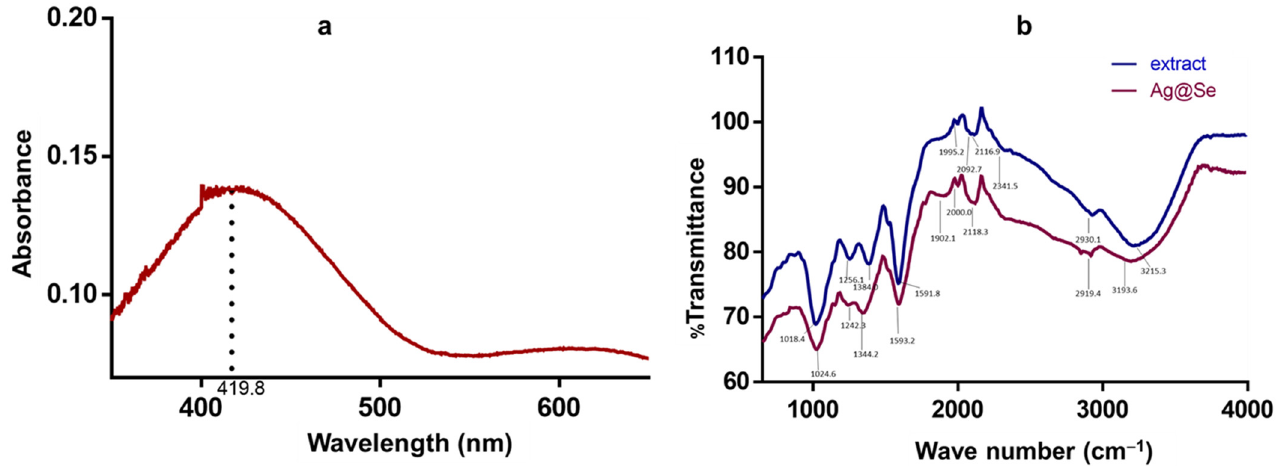
Figure 1. ( a ) Ultraviolet-visible spectrum of the Ocimum tenuiflorum synthesized Ag@Se nanoparticles, and ( b ) FTIR spectra of the Ocimum tenuiflorum extract and green-synthesized Ag@Se nanoparticles.